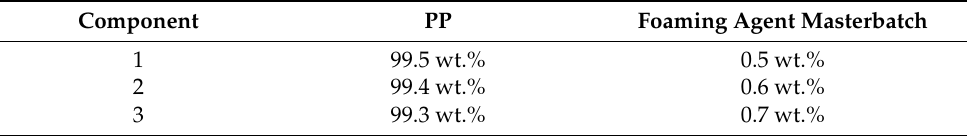
Table 1. The proportion table of PP composite foam material.